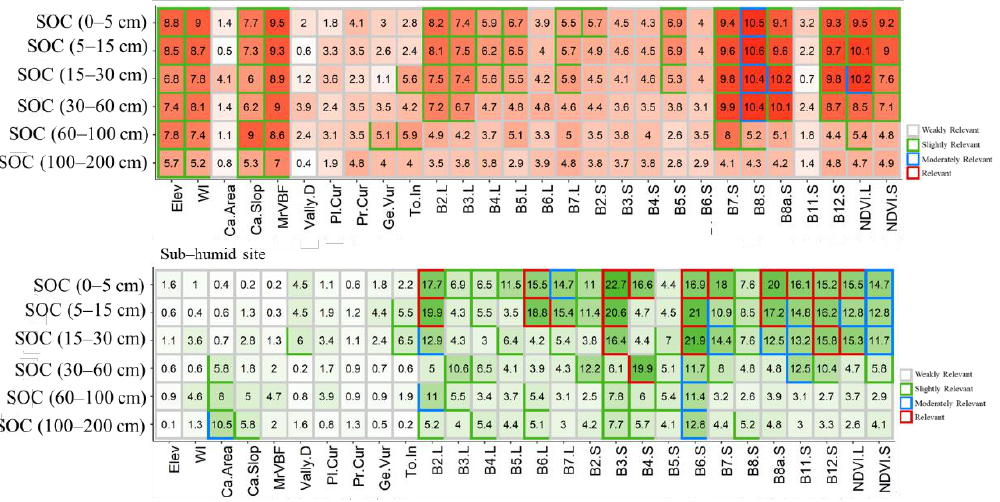
Figure 4. Box plot of SOC content at six standard depths at the two regions. Different letters (a:d) indicate a significant difference of mean SOC content at the 0.05 level.